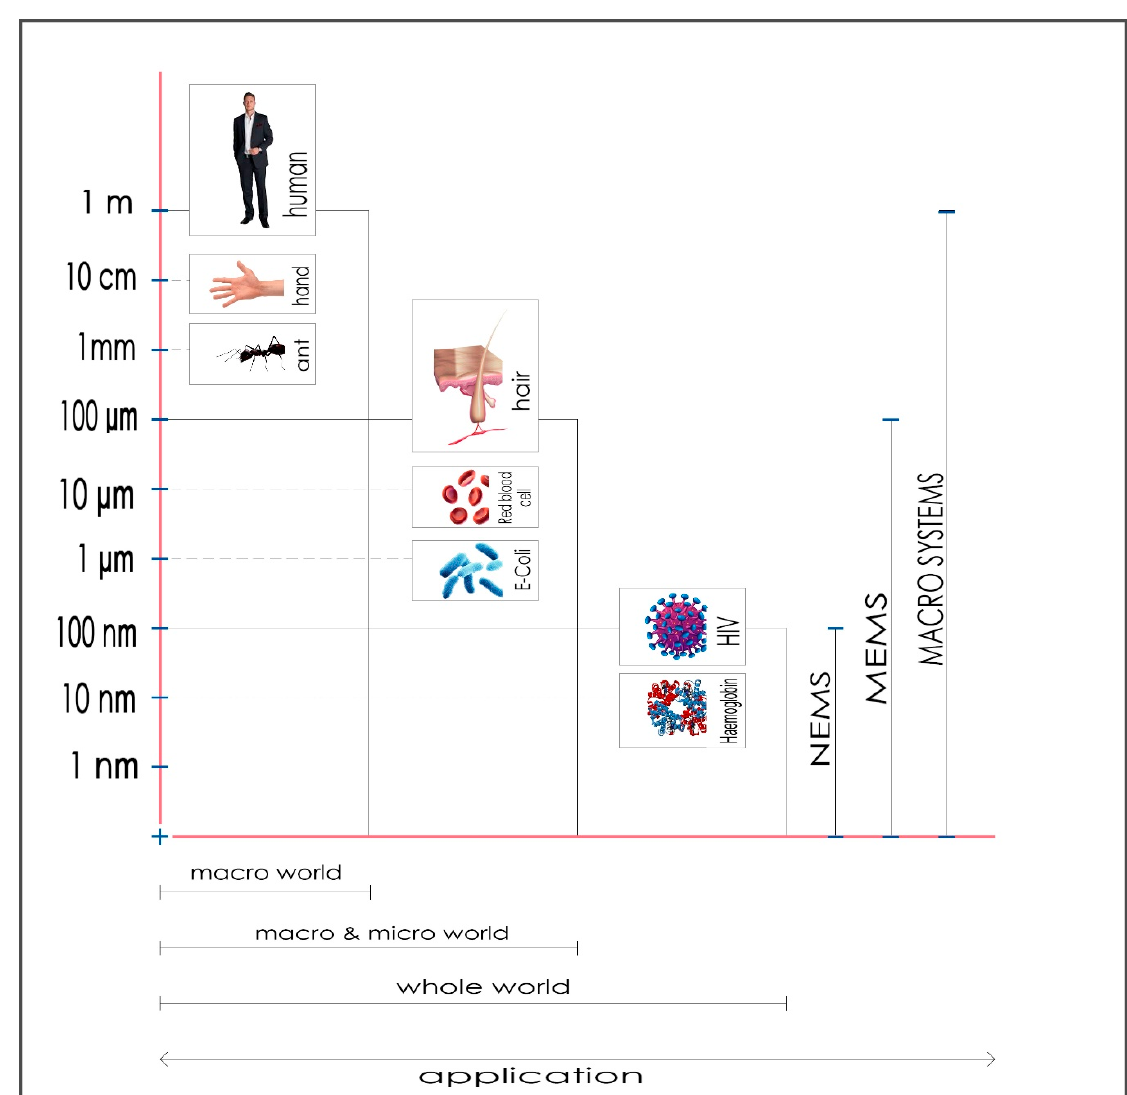
Figure 1. Different scales in